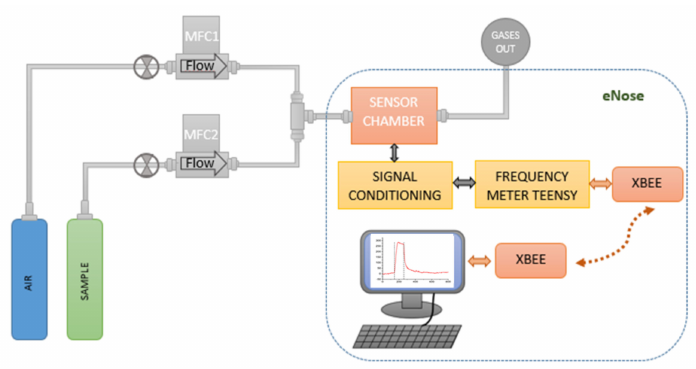
Figure 4. Experimental setup for the eNose